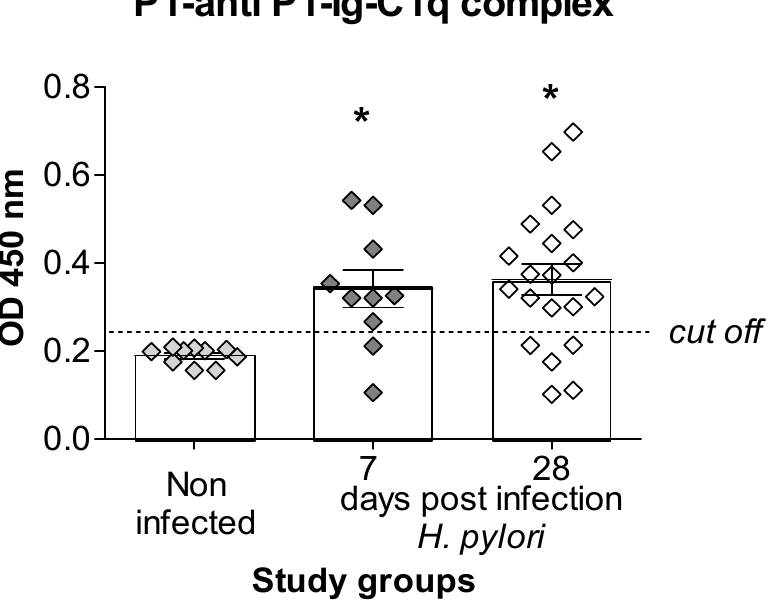
Figure 3. Detection of anti-P1-antibodies, which bind C1q subunit of complement, by the ELISA in serum samples of Caviae porcellus infected with H. pylori. Serum samples were added to microtiter plates coated with P1 peptide, and after binding with anti-P1 antibodies, the plates were incubated with C1q. The P1-anti-P1 IgG-C1q complexes were detected using anti-C1q antibodies labeled with horseradish peroxidase (HRP). The sera were collected from control animals noninfected with H. pylori , n = 10, or infected with these bacteria, 7 days, n = 10 or 28 days, n = 20, after the last inoculation with H. pylori . Shown are mean values ± standard deviation (SD). P1, synthetic peptide containing the amino acid sequence (TVLLPLVIFF) of Caviae porcellus tumor necrosis factor receptor (TNFR). The square in the figure represents an individual data. Statistical significance: * p <